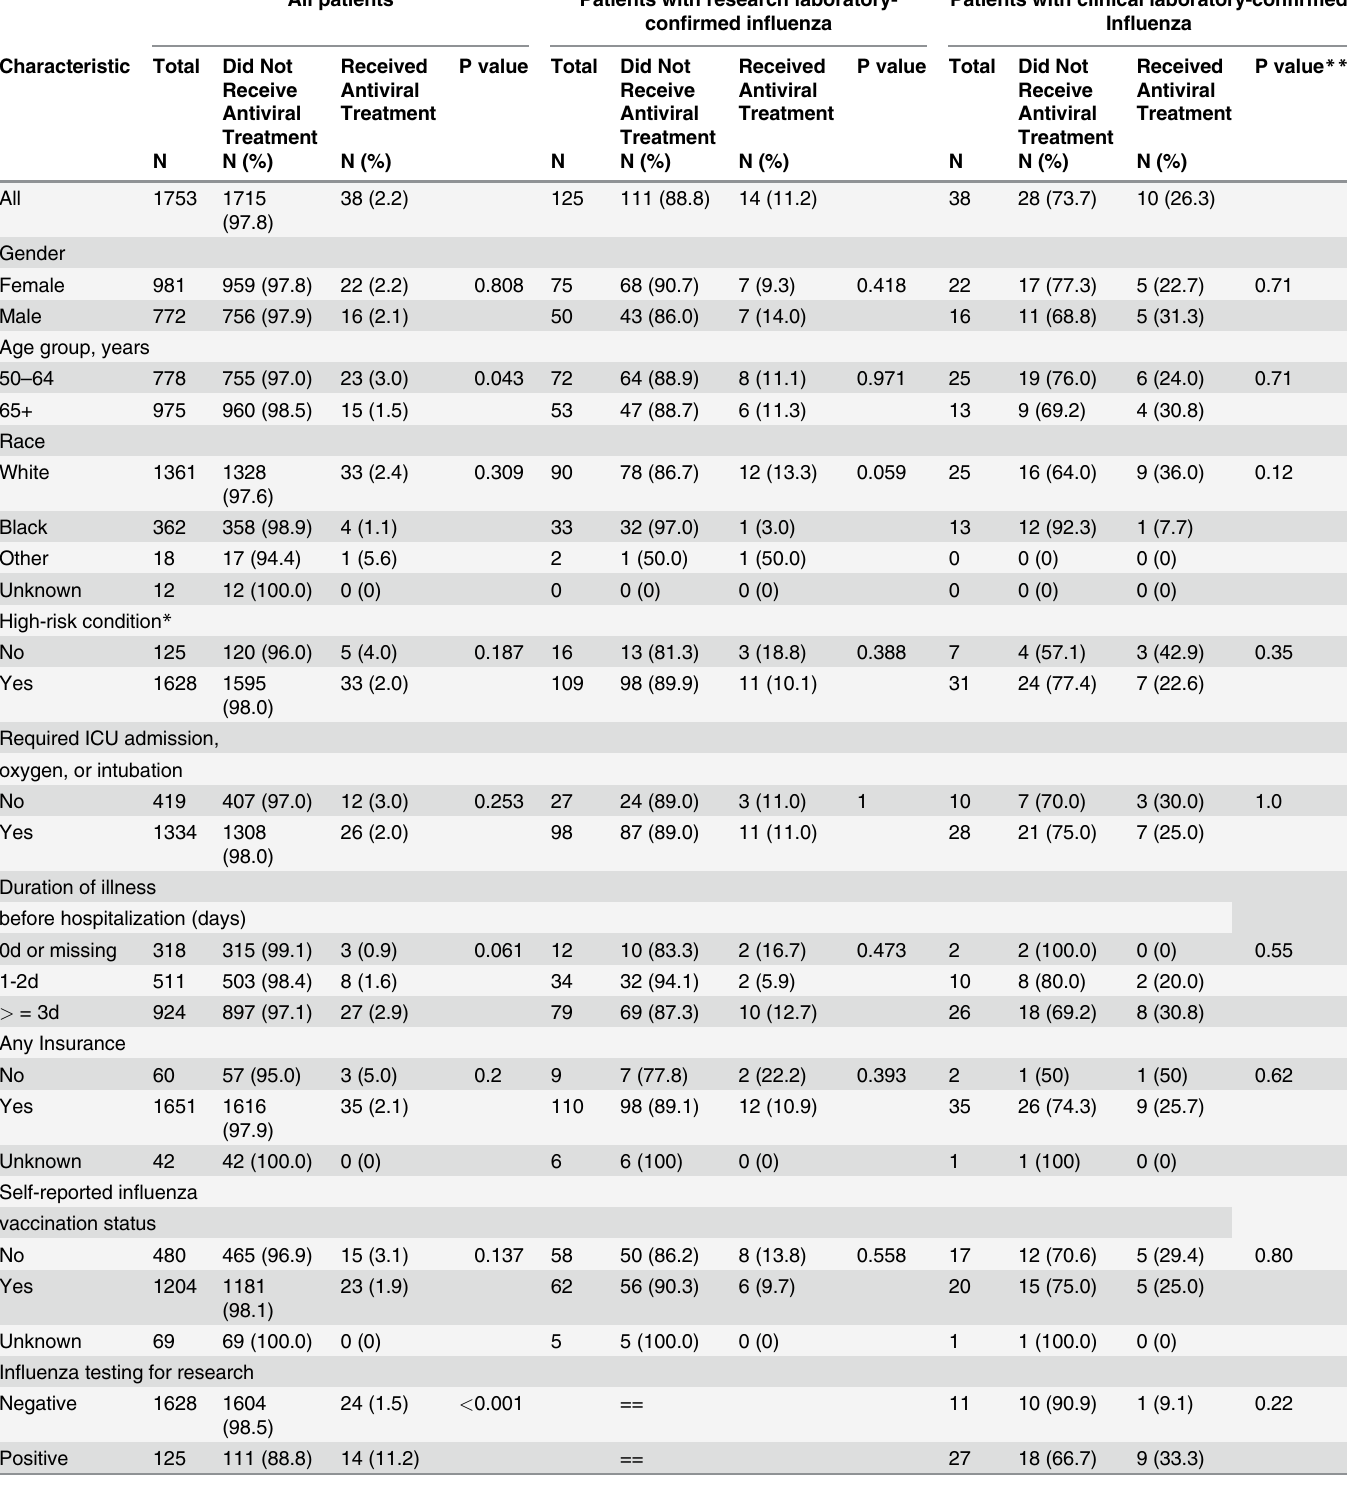
Table 2. Characteristics of Adults 50 years and older Hospitalized with Symptoms of Respiratory Illness or Non-localizing fever during 2006 – 2012 Influenza Season, by Antiviral Treatment Status. All patients Patients with research laboratory- Patients with clinical laboratory-con fi rmed con fi rmed in fl uenza In fl